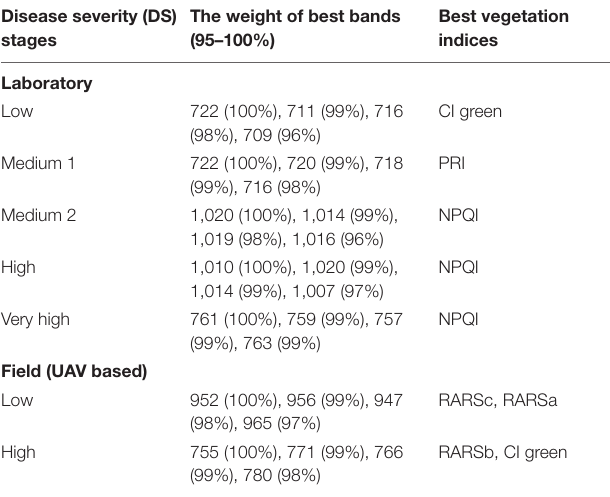
TABLE 2 | Best wavebands and vegetation indices measured in the laboratory and field for detecting different disease severity stages of downy